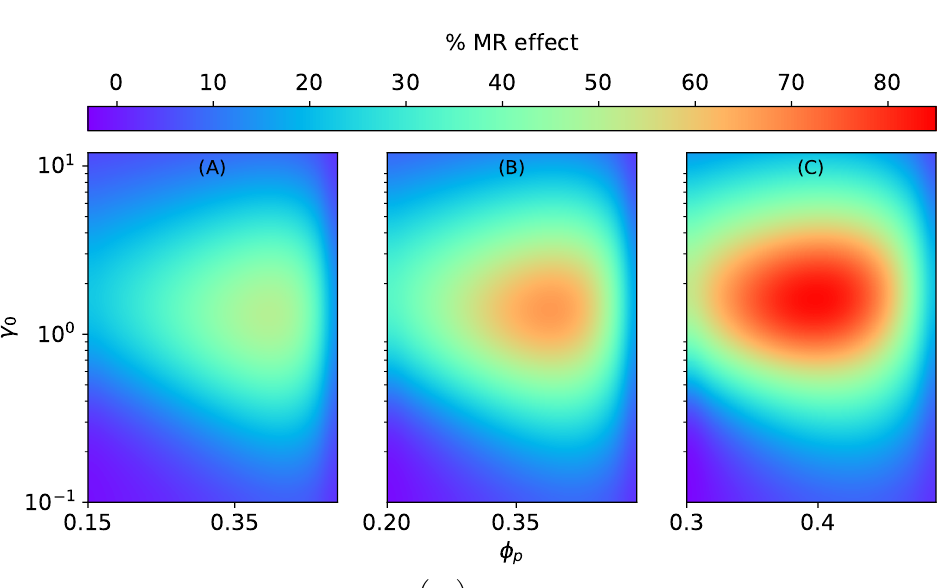
Figure 6. The magneto-rheological effect stretched along the field direction at constant | (cid:126) H 0 | = 470 kA/m, G m = 17 kPa. ( A ) φ = 0.15, ( B ) φ = 0.2, ( C ) φ =